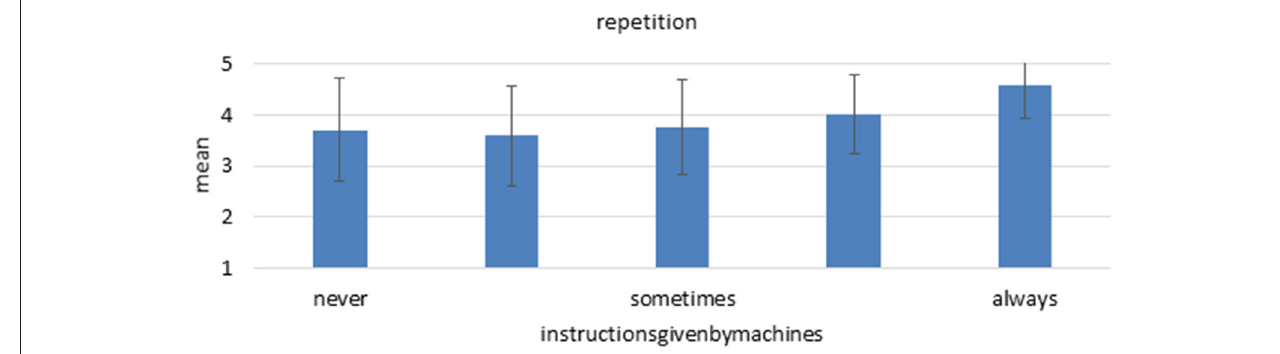
FIGURE 7 | Mean and standard deviation of the item “repetition” among the different “instructions by machines.” n = 2,361, linear regression coefficient beta = 0.184, p <